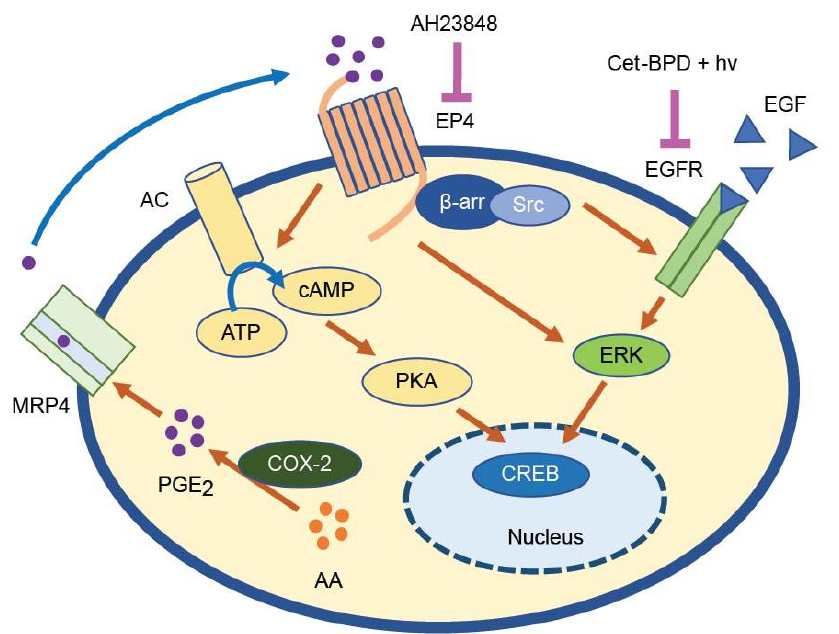
Figure 6. Proposed relationship between the combination treatment (Cet-BPD-based PDP and AH23848) and EGFR-EP4 signal transduction pathways. Arachidonic acid is converted to PGE 2 by COX-1, COX-2, and PGE synthase [38]. PGE 2 is exported from the cell via multiple drug resistance- associated protein 4 (MRP4), where it can bind to the G-protein coupled receptors, EP1–4 [39]. EP4 is coupled to the G protein alpha stimulator (Gs), which activates adenylyl cyclase. Adenylyl cyclase converts adenosine triphosphate (ATP) to cyclic adenosine monophosphate (cAMP), which subse- quently activates Protein Kinase A (PKA). When PKA is activated, its catalytic subunits translocate into the nucleus and activate CREB, a transcription factor with complex roles in cancer [40]. EGFR can be activated extracellularly via EGF binding and intracellularly via the EP4/ β -arrestin ( β -arr)/Src complex [18]. Activated EGFR causes a variety of downstream effects including ERK phosphorylation, which is linked to CREB activation. EP4 has also been shown to induce ERK activation independently of EGFR [41]. The Cet-BPD and EP4 inhibitor combination regimen is designed to simultaneously abrogate EGFR and EP4 signaling to block tumorigenic crosstalk along with overlapping signaling pathways. Abbreviations: AA (arachidonic acid); COX2 (cyclooxygenase-2); PGE2 (prostaglandin E2); MRP4 (multidrug resistance-associated protein 4); EP4 (prostaglandin E2 receptor 4); ATP (adenosine triphosphate); cAMP (cyclic adenosine monophosphate); PKA (protein kinase A); CREB (cyclic AMP response element-binding protein); ERK1/2 (extracellular signal-regulated kinases 1/2); β - arr ( β -Arrestin); EGFR (epidermal growth factor receptor); EGF (epidermal growth factor); BPD (benzoporphyrin derivative); Cet (cetuximab).